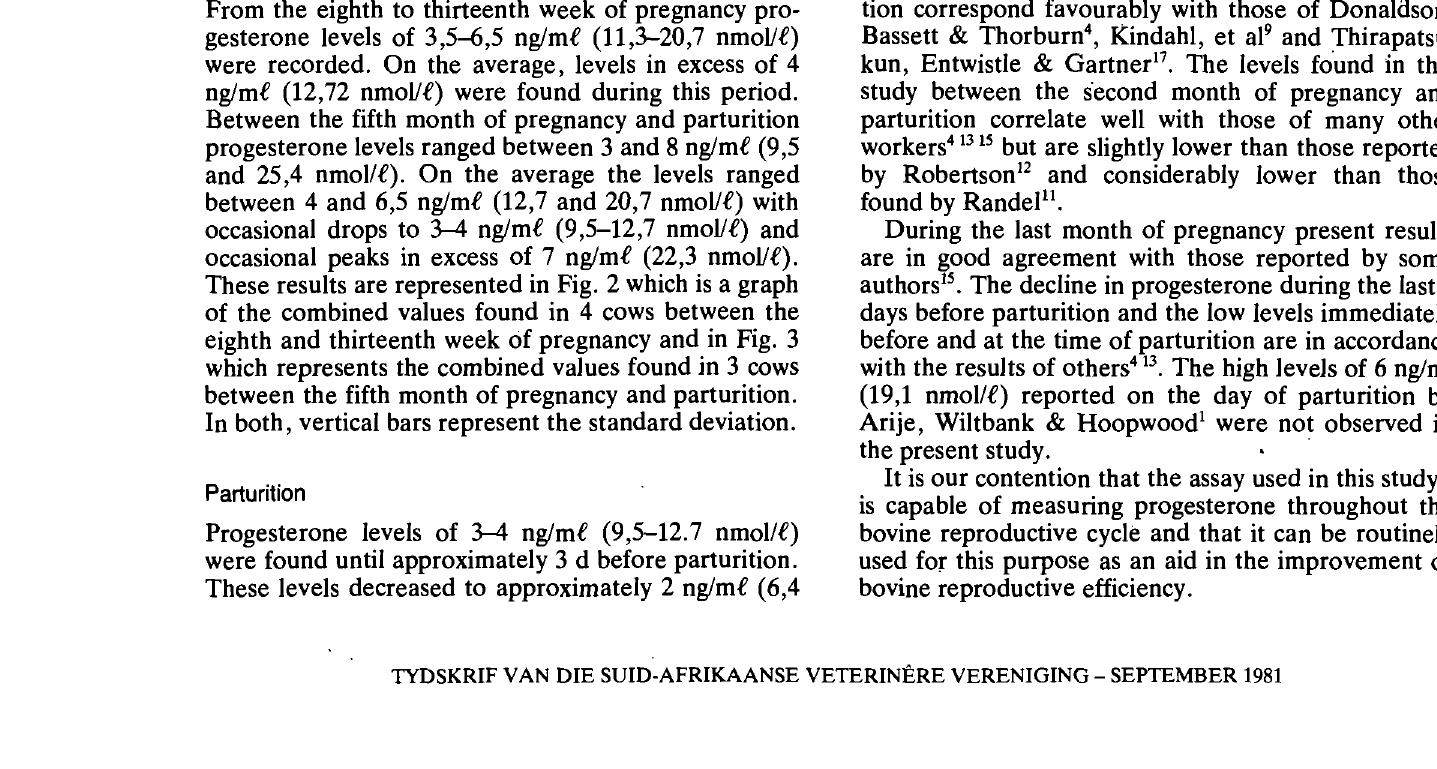
Fig. 3 Progesterone concentrations in 3 cows from the fifth month of pregnancy